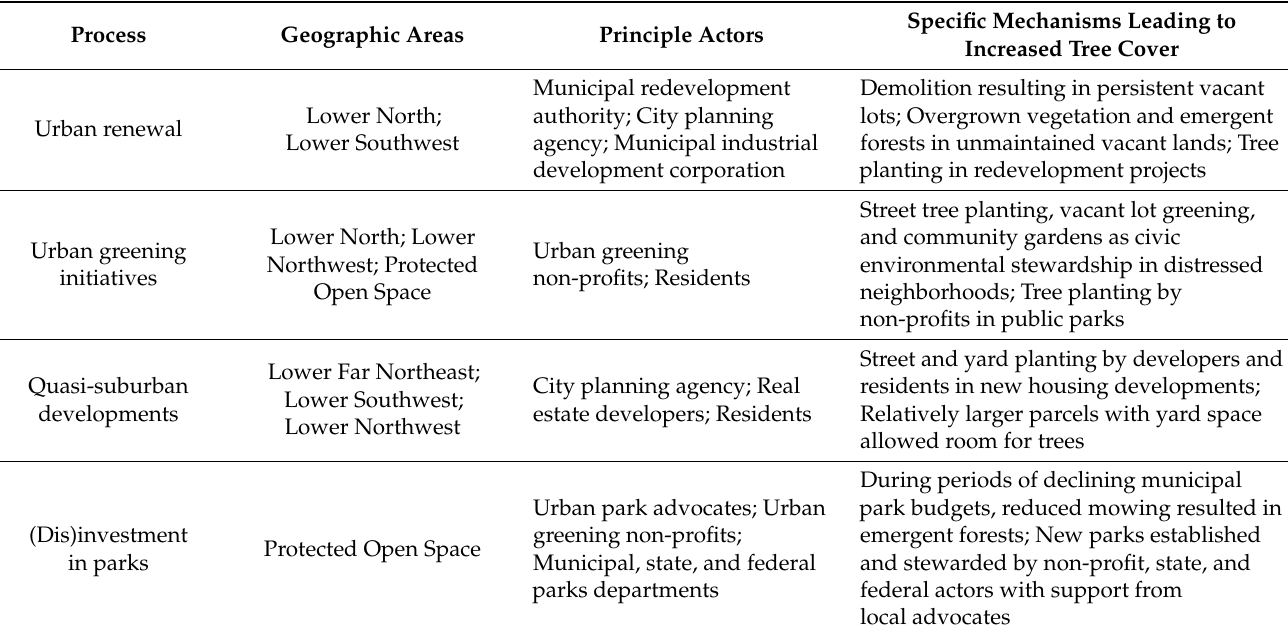
Table 5. Processes leading to increased tree cover in post-industrial